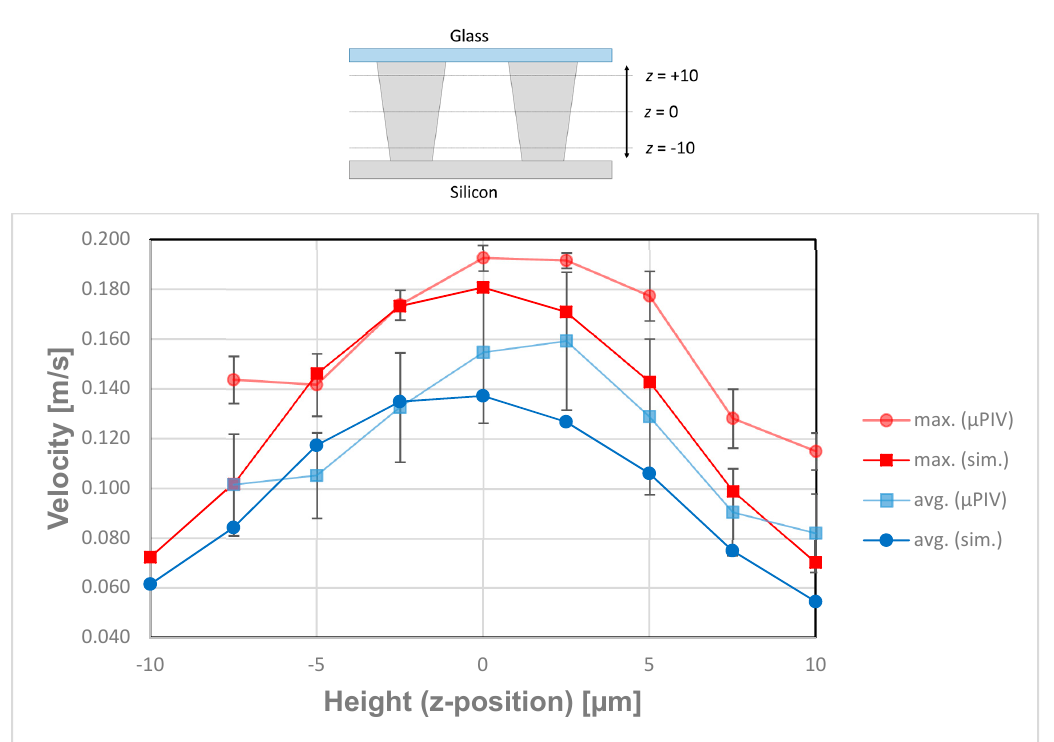
Figure 15. Maximum and averaged velocities at Re = 1.52 between neighboring posts obtained by µPIV and simulations for varied focal depth (z-axis within the array). For this evaluation, for every layer, four rectangle areas between posts were chosen out of the µPIV velocity fields and the velocity maxima and mean values of these four areas were averaged.